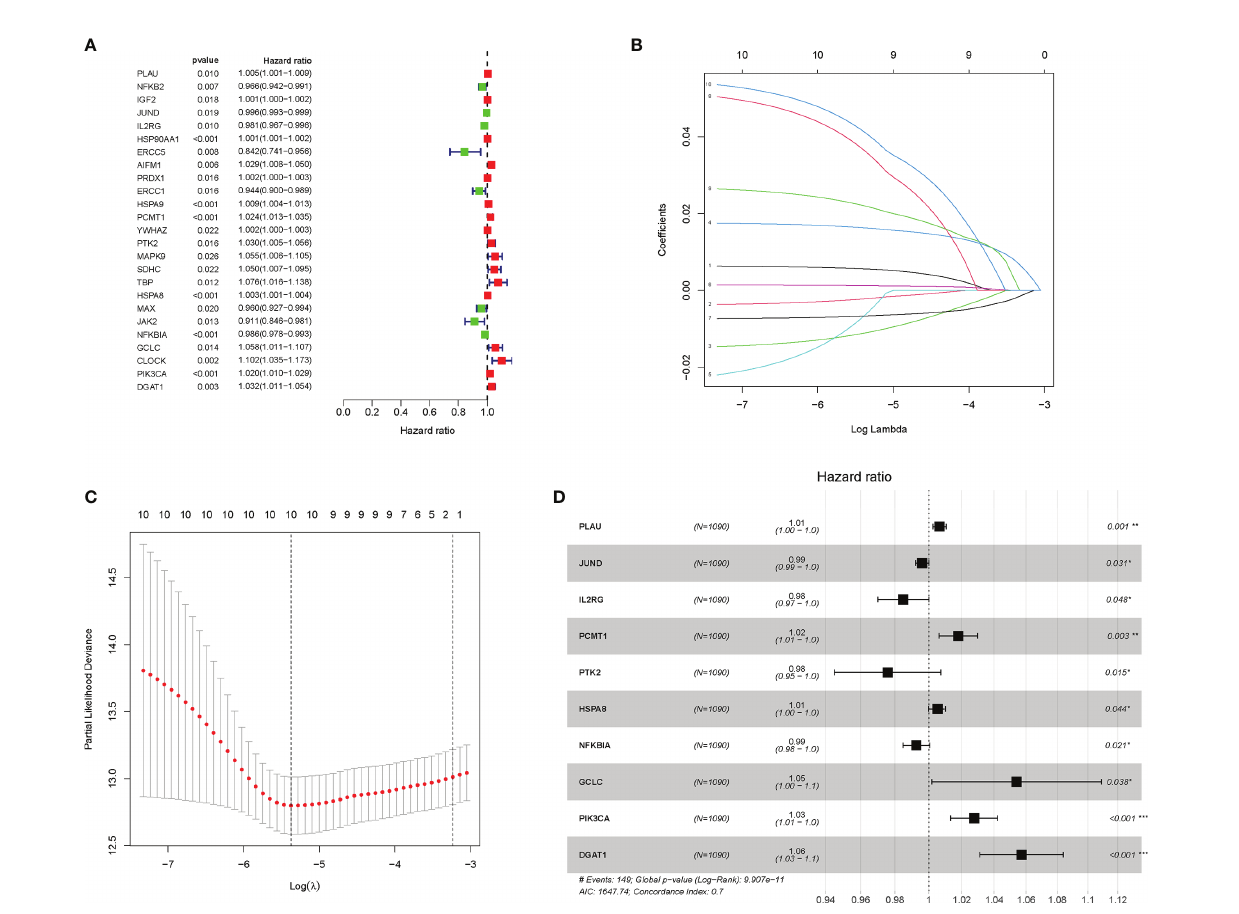
FIGURE 2 | Construction and validation of the aging-related gene (AG)-related risk model with prognostic value in breast cancer (BC). (A) The prognostic genes associated with overall survival (OS) were identi fi ed by the univariate Cox analyses. (B, C) In the least absolute shrinkage and selection operator (LASSO) regression analysis of The Cancer Genome Atlas (TCGA), the value of the super parameter l was veri fi ed by 10-fold cross-validation. (D) Forest plot showing the hazard ratio (HR) for the association between prognostic ability of the 10 AGs and OS. *P < 0.05; **P < 0.01; ***P <